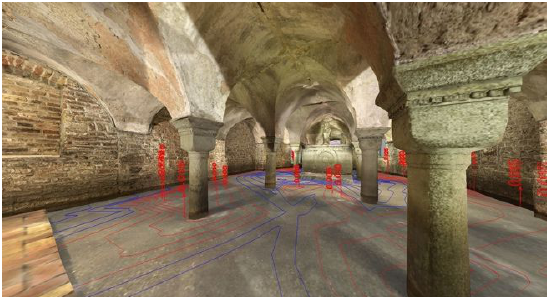
Figure 5. Example of a dimensional analysis of the flooring performed with EasyCUBE PRO: Advanced 3D model of an historical